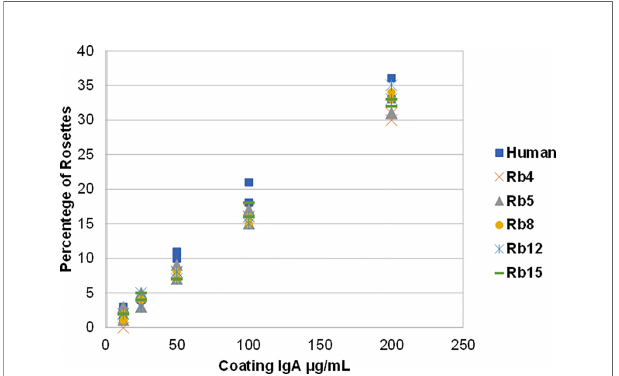
FIGURE 4 | Binding of hIgA1 and rabbit hinge hybrids to human neutrophils assessed by rosette formation. Sheep erythrocytes were coated with different amounts of the immunoglobulins (from 12.5 to 200 m g/mL), and for each condition the percentage of rosettes formed was counted twice (represented in the graph). The experiment was performed twice with the results shown representing a typical experiment.